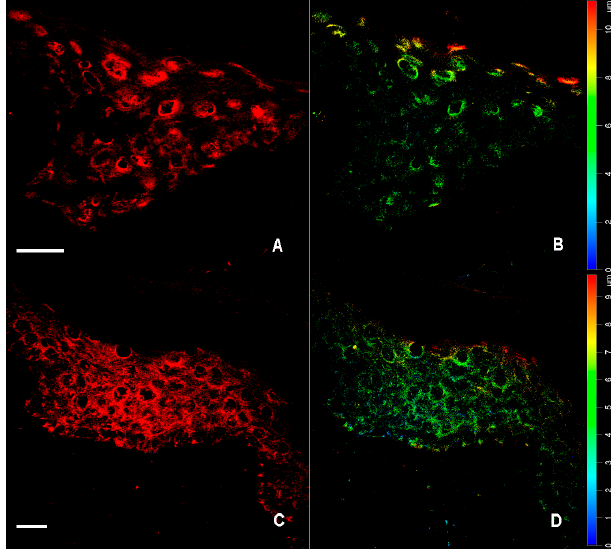
Figure 4. White/lesional vitiligo skin: immunofluorescence staining of nNOS ( A – C ); Confocal image obtained in “overlay” mode showed a moderate nNOS expression in white/lesional skin ( B – D ). Three-dimensional reconstruction of the same confocal image obtained in “depth coding” mode. The colors reveal the spatial distribution (arrangement) of nNOS throughout the thickness of the section. ( A , B ) Argon laser (568 nm) lens 3, zoom 1,2, original magnification 40×. bar = 25 µm; ( C , D ) Argon laser (568 nm) lens 3, zoom 1 , original magnification 40× bar = 20 µm.